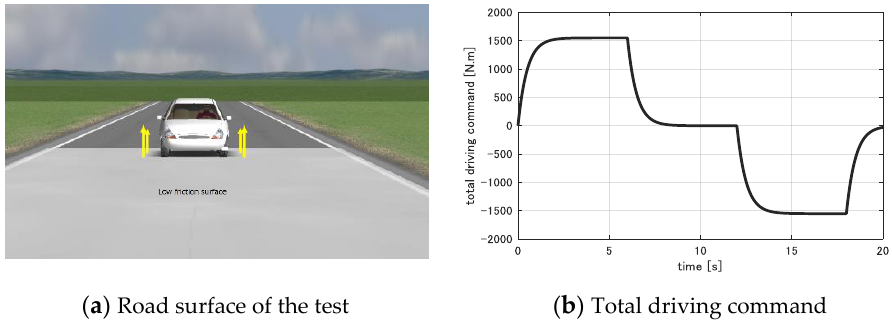
Figure 20. Simulation setting for evaluating LQR-based slip-ratio control using DM-3.